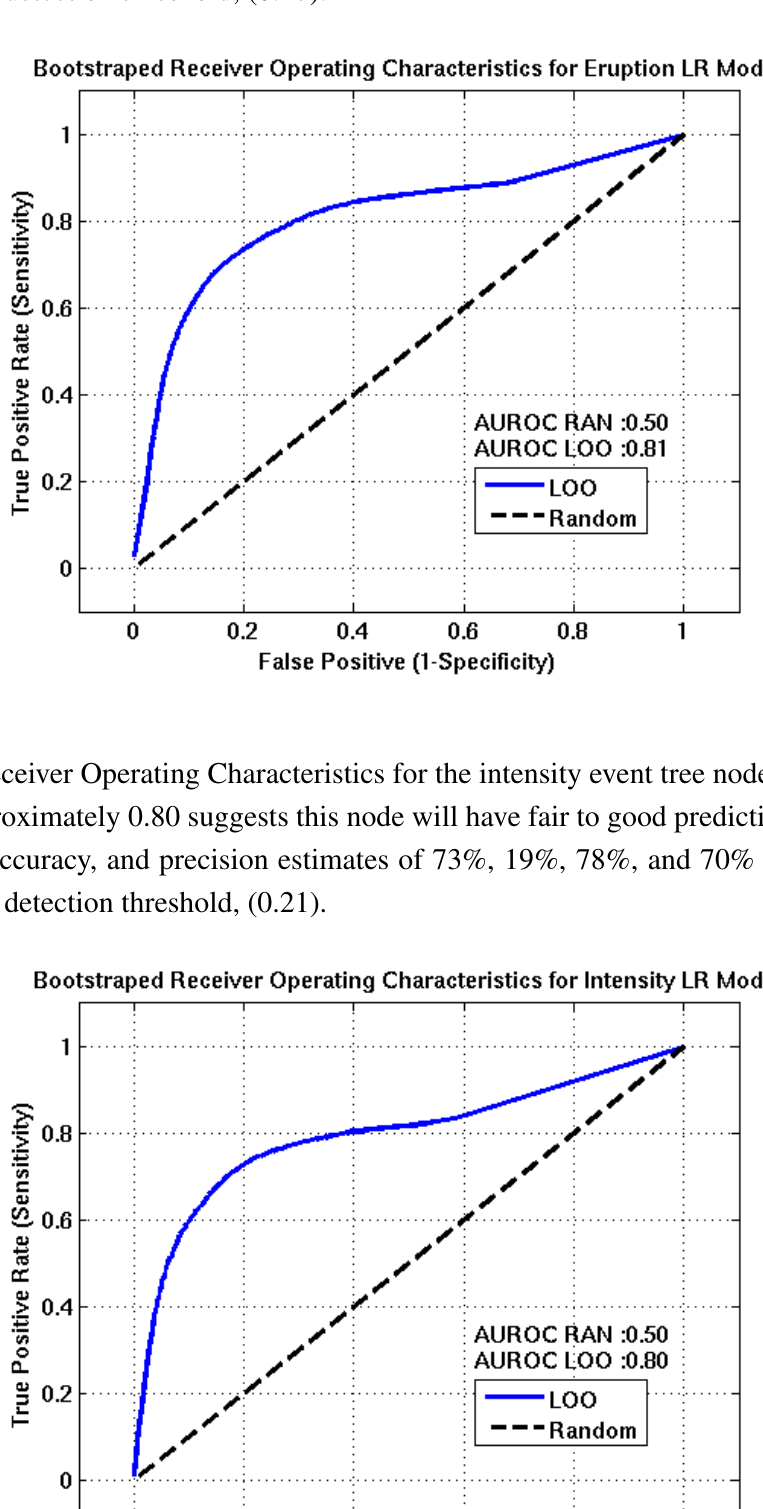
Figure 6. Receiver Operating Characteristics for the eruption event tree node. The AUROC value of approximately 0.81 suggests this node will have fair to good predictive capabilities. TPR, FPR, accuracy, and precision estimates of 75%, 21%, 78%, and 74% are obtained at the optimum detection threshold, (0.47).